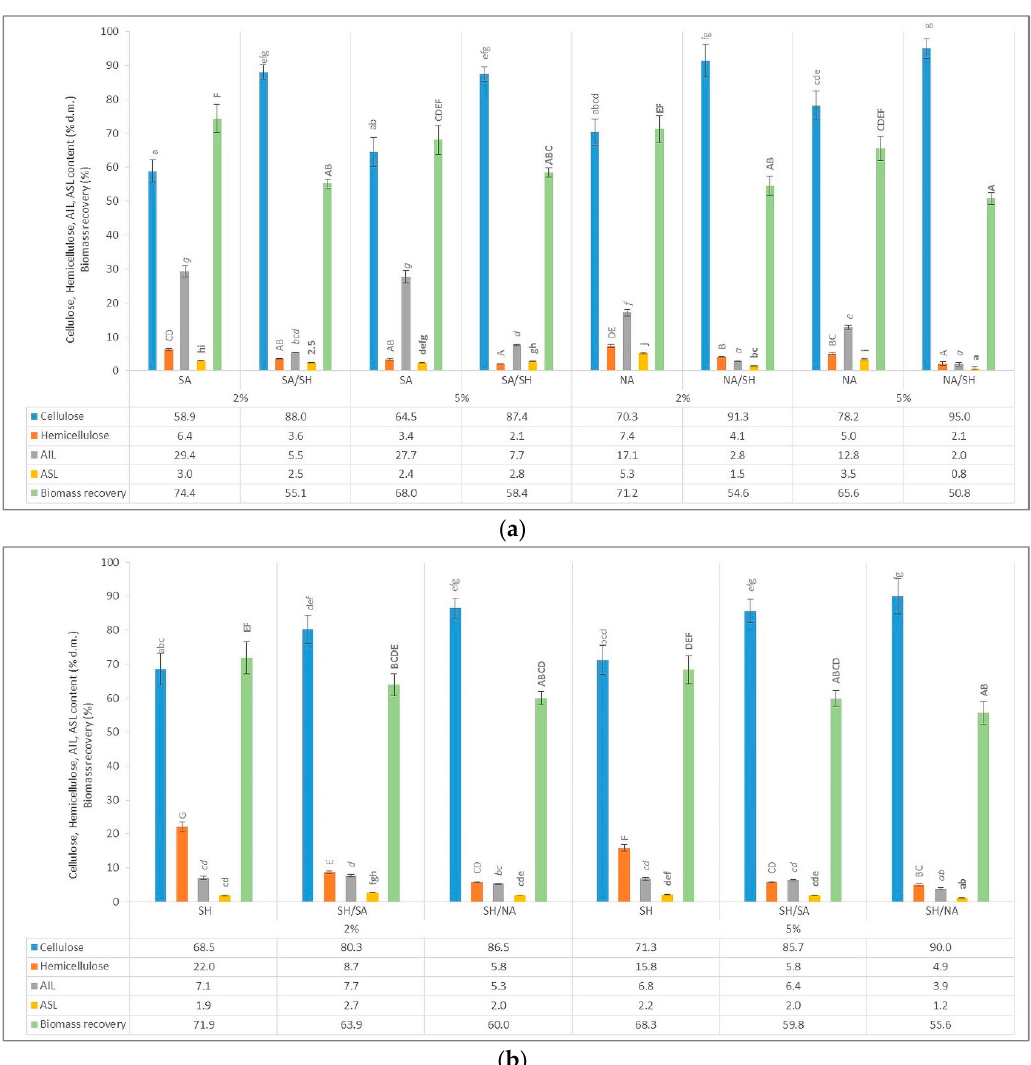
Figure 2. E ff ect of single and two-stage acid-alkali ( a ) and alkali-acid ( b ) pretreatment on the chemical composition of pretreated OS and biomass recovery. SA—sulfuric acid; NA—nitric acid; SH—sodium hydroxide; AIL—acid insoluble lignin; ASL—acid-soluble lignin. Different lower-case letters indicate significant differences (p < 0.05) between the mean values of the cellulose content (two-way ANOVA, Tukey’s post-hoc test). Different capital letters indicate significant differences (p < 0.05) between the mean values of the hemicellulose content (two-way ANOVA, Tukey’s post-hoc test). Different lower-case letters in italic, indicate significant differences (p < 0.05) between the mean values of the AIL content (two-way ANOVA, Tukey’s post-hoc test). Different lower-case letters in bold, indicate significant differences (p < 0.05) between the mean values of the ASL content (two-way ANOVA, Tukey’s post-hoc test). Different capital letters in bold, indicate significant differences (p < 0.05)